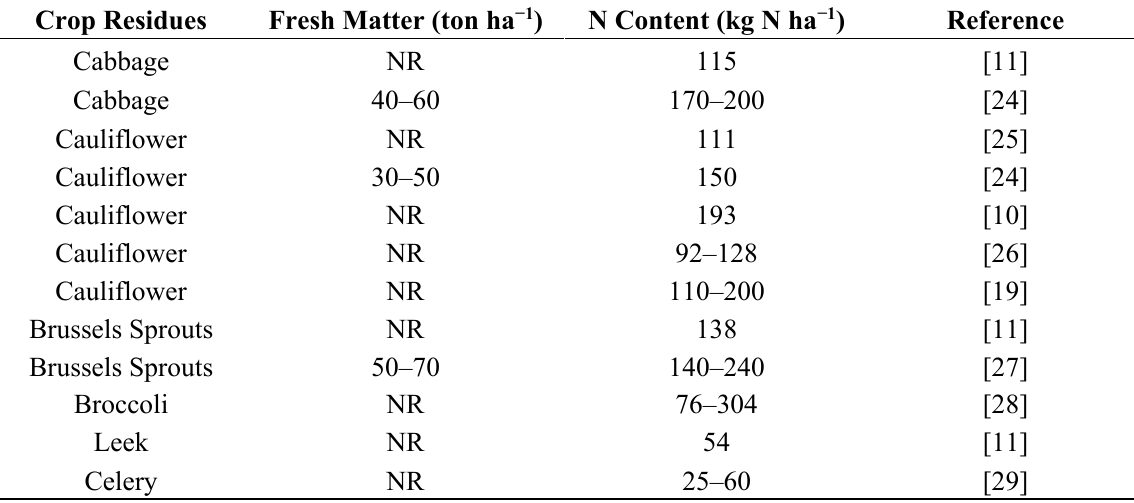
Table 2. Fresh biomass and N content of vegetable crop